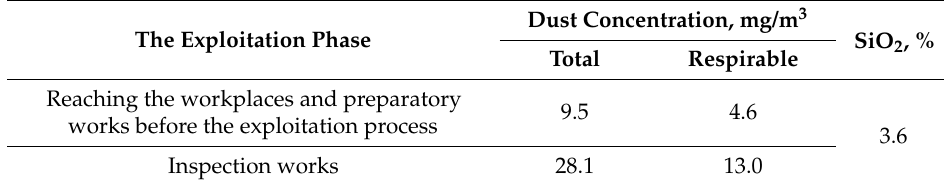
Table 13. The measurement results for the dust levels for selected activities, in the working position the shift